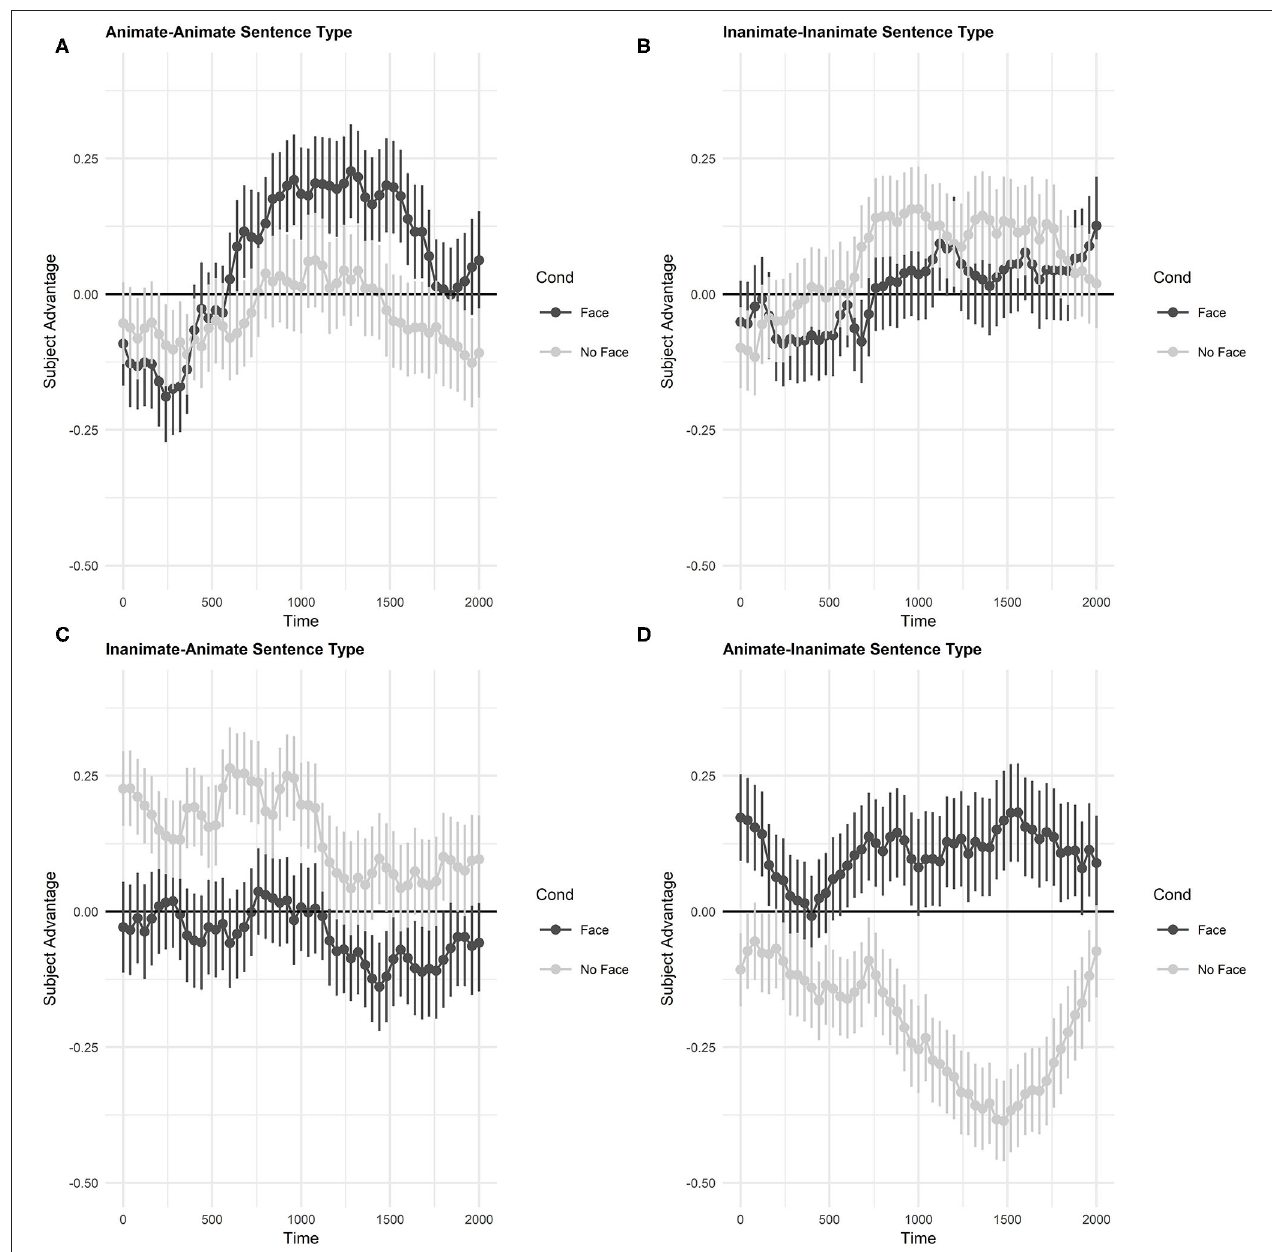
FIGURE 3 | Child proportional eye tracking data by sentence type and image condition. Subject Advantage values represent looks to the subject interest areas minus looks to the object interest areas. Error bars represent standard error. (A) Animate-animate sentence type. (B) Inanimate-inanimate sentence type. (C) Inanimate-animate sentence type. (D) Animate-inanimate sentence type.